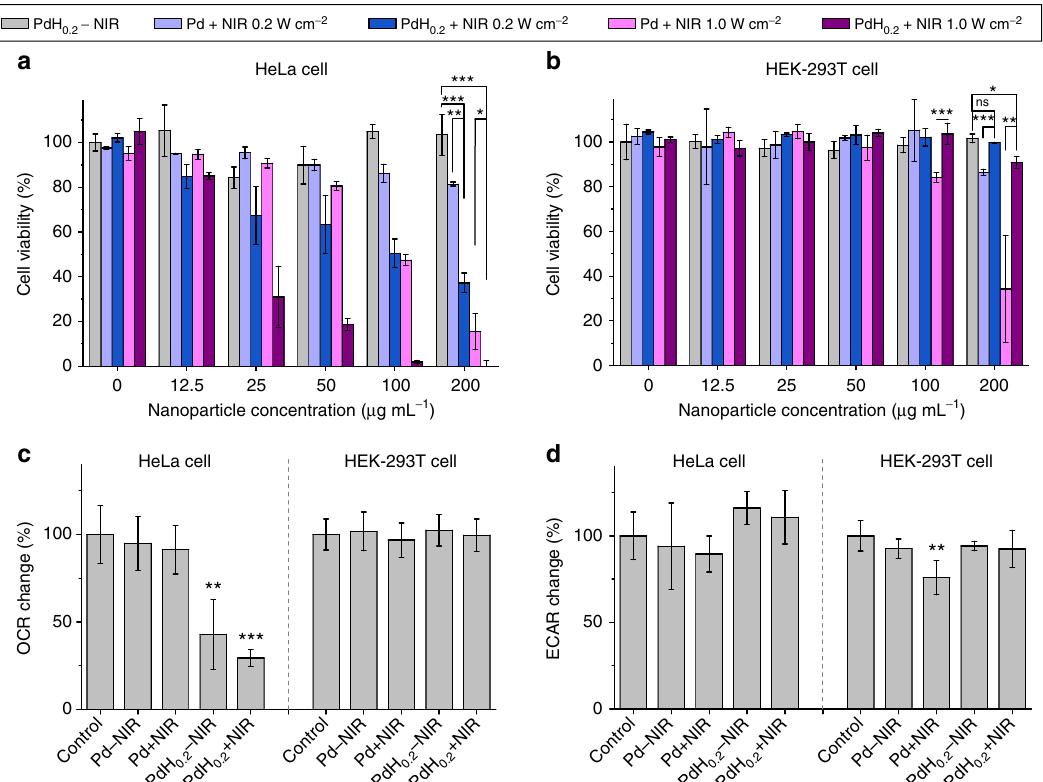
Fig. 5 In vitro and In vivo therapy ef fi cacies of PdH 0.2 nanocrystals. a , b In vitro outcomes of combined hydrogenothermal therapy to HeLa cancer cells ( a ) and HEK-293T normal cells ( b ) ( n = 8). c , d The mitochondrial (oxidative phosphorylation, c ) and non-mitochondrial (glycolysis, d ) metabolism behaviours of HeLa cells and HEK-293T cells ( n = 4). Mean value and error bar are de fi ned as mean and s.d., respectively. P values were calculated by two-tailed Student ’ s t -test ( ***P < 0.005, **P < 0.01, *P < 0.05), and ns represented no signi fi